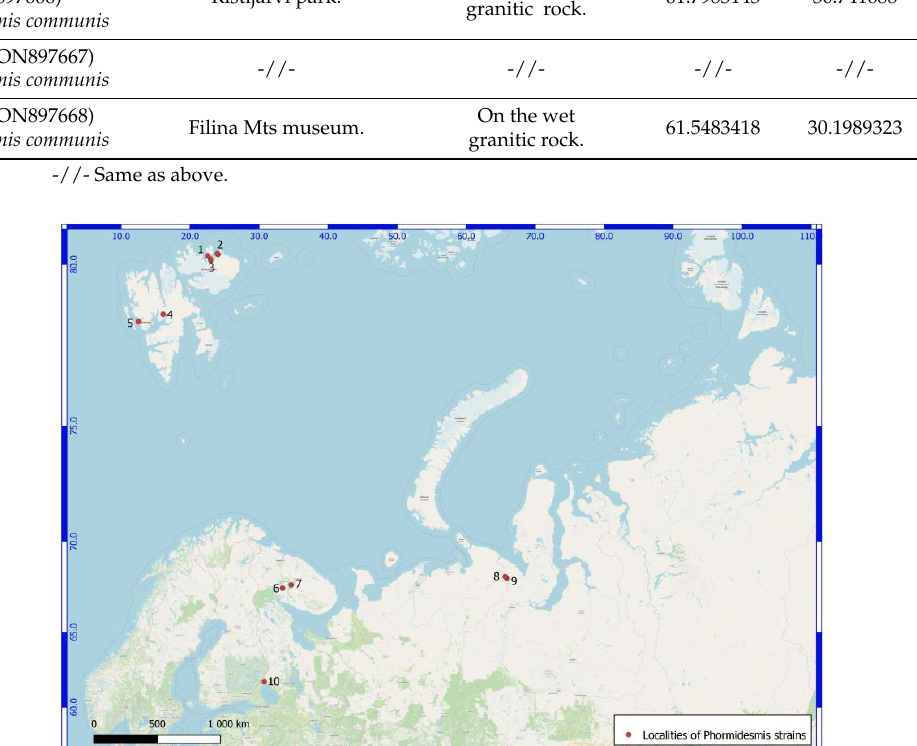
Figure 1. Position of sample plots of Phormidesmis strains, numbers of sample plots as in the Table